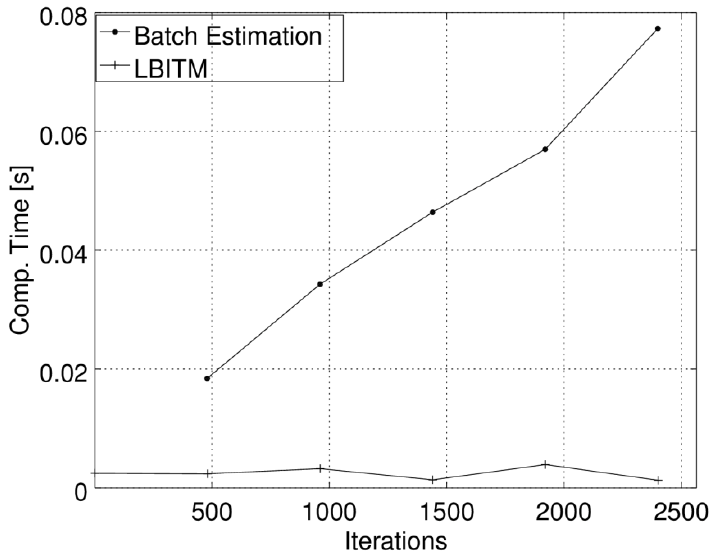
Figure 4. Computational times at different moments of the evolution of the algorithm for the batch estimation method and the Bayesian inference.